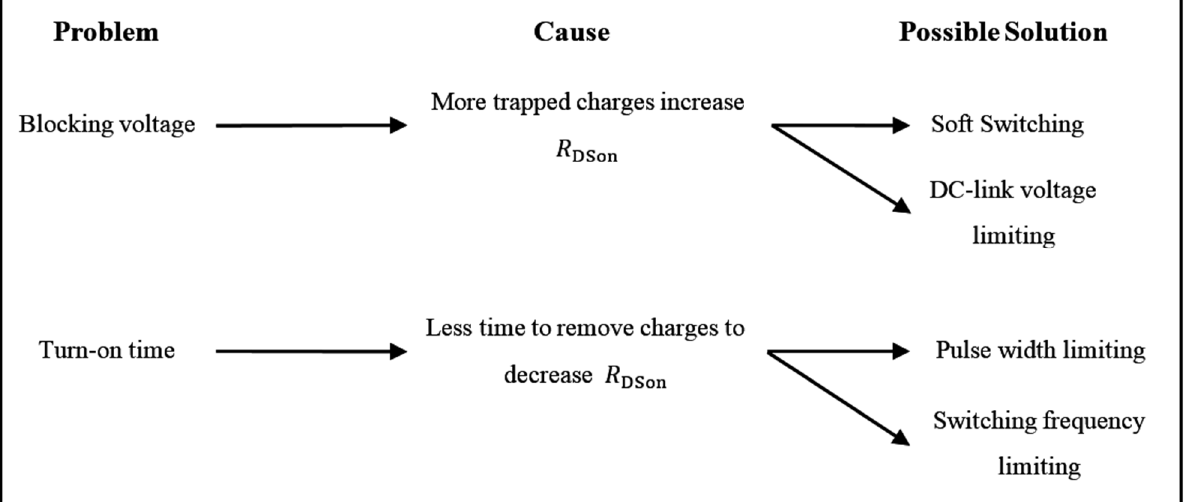
Figure 3. Problems connected with current-collapse, their causes, and possible solutions.